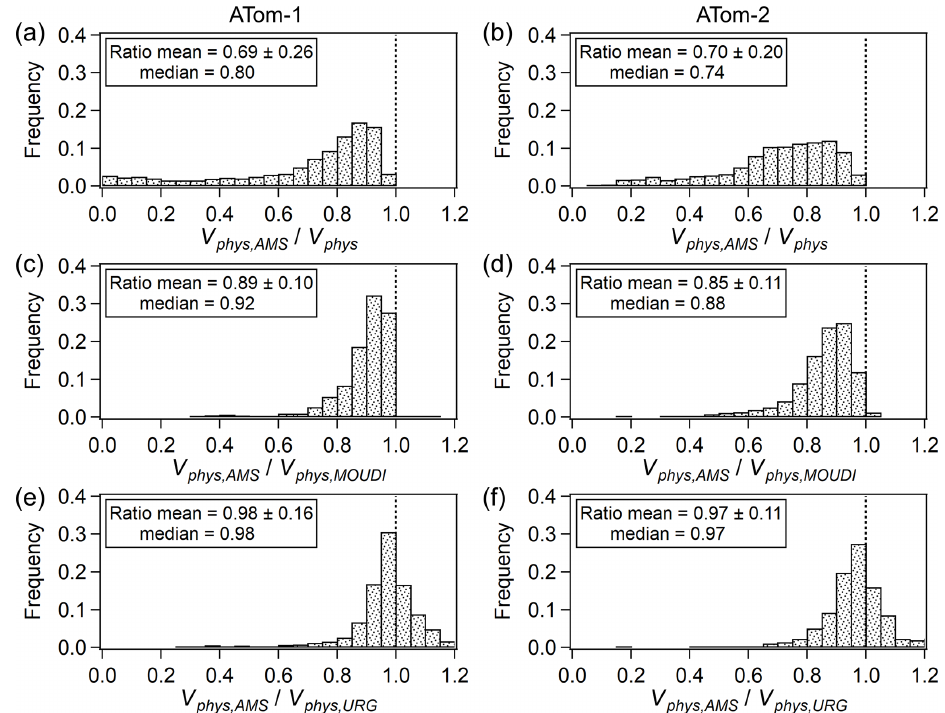
Figure 7. (a, b) Frequency distributions of the AMS-transmission-corrected V phys ( V phys , AMS ) vs. the (total) V phys . (c, d) Same for V phys , AMS vs. the dry condition altitude-dependent MOUDI 1µm stage-impactor-transmission-corrected V phys ( V phys , MOUDI ). (e, f) Same for V phys , AMS vs. the ground level ambient condition URG-PM 1 -corrected (standard PM 1 cut) V phys ( V phys , URG ). ATom-1 is shown on the left and ATom-2 on the